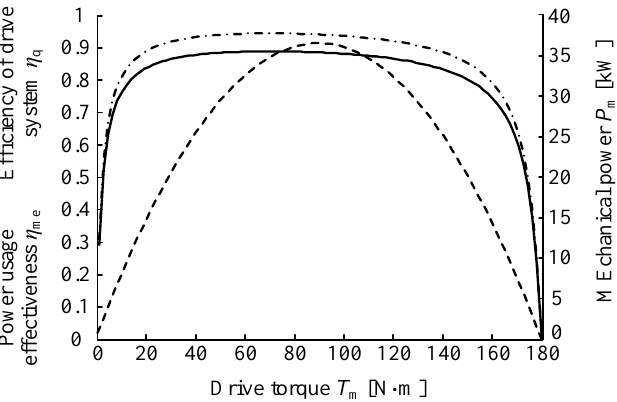
( b ) Test result of optimization scheme aimed at η Figure 6. Cont